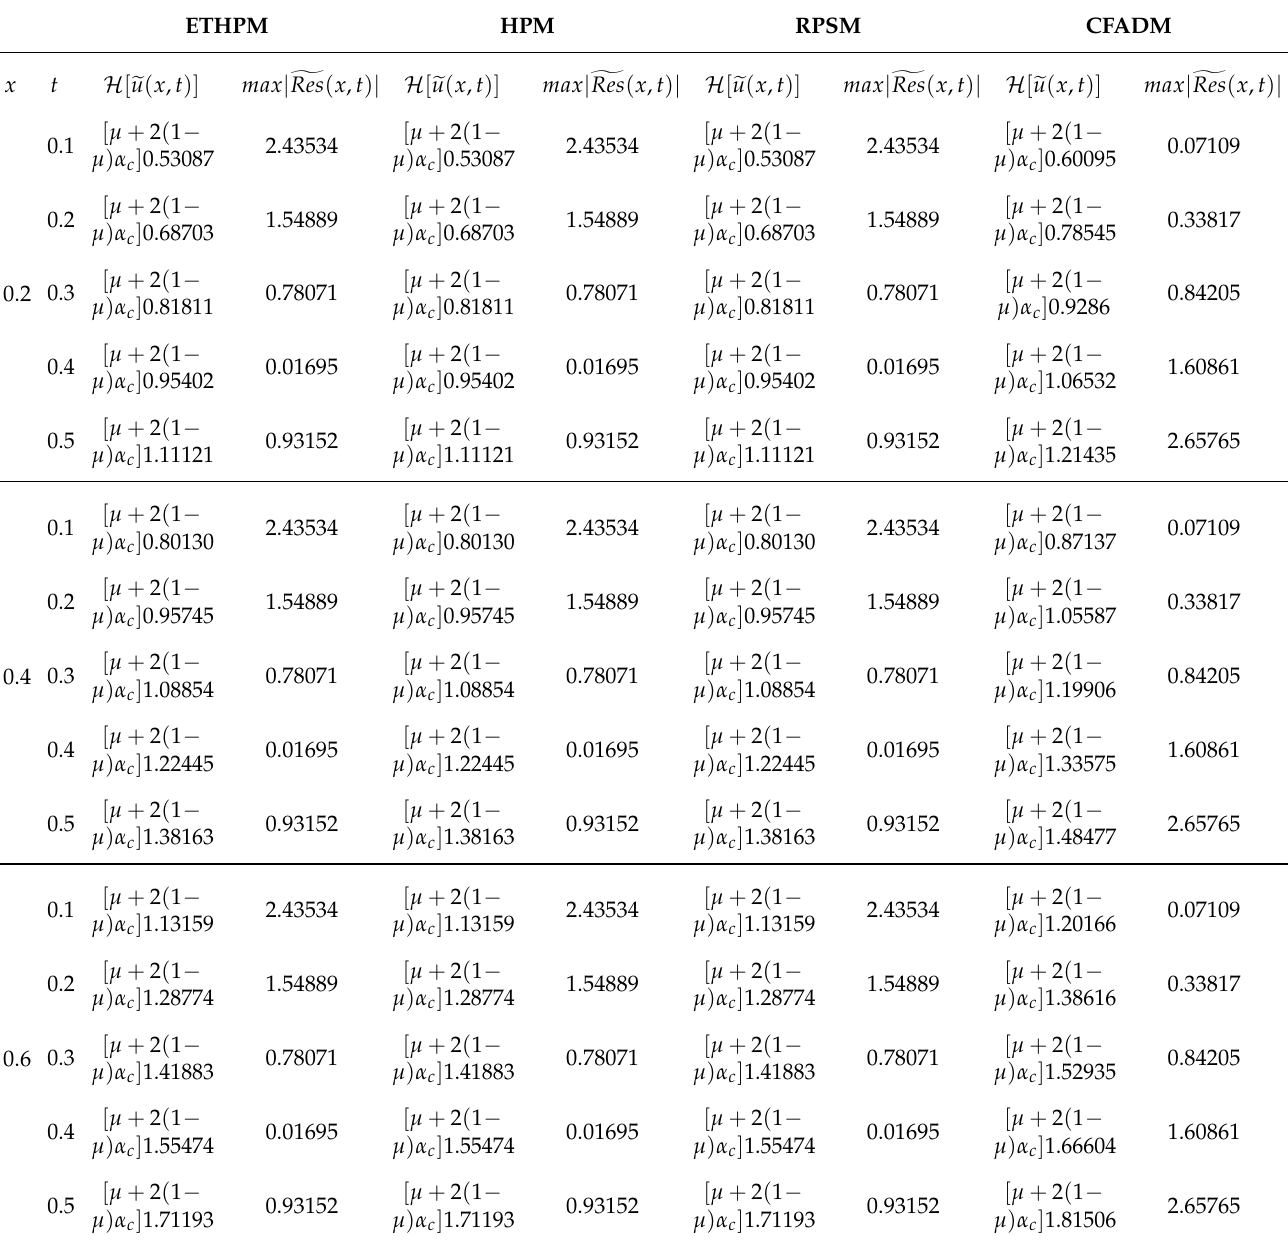
Table 2. H [ (cid:101) u ( x , t )] and max | (cid:103) Res ( x , t ) | by ETHPM, HPM, RPSM, CFADM for α = 0.75, k =